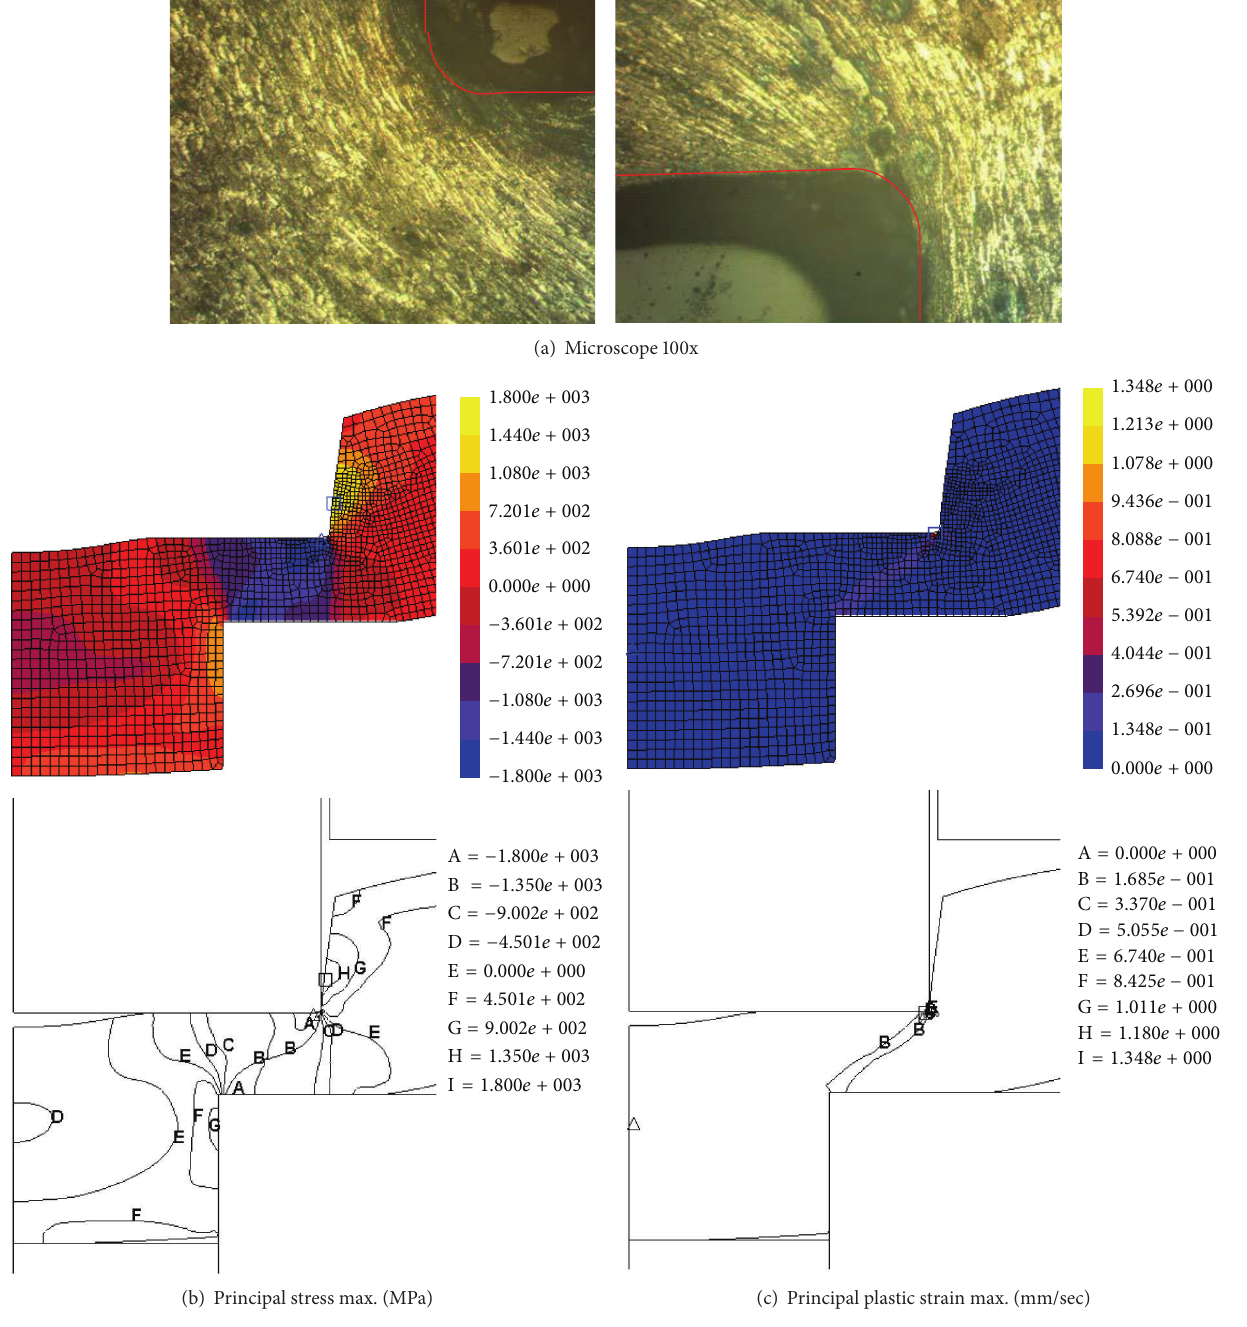
Figure 11: Microstructure behavior analysis for 80% punch